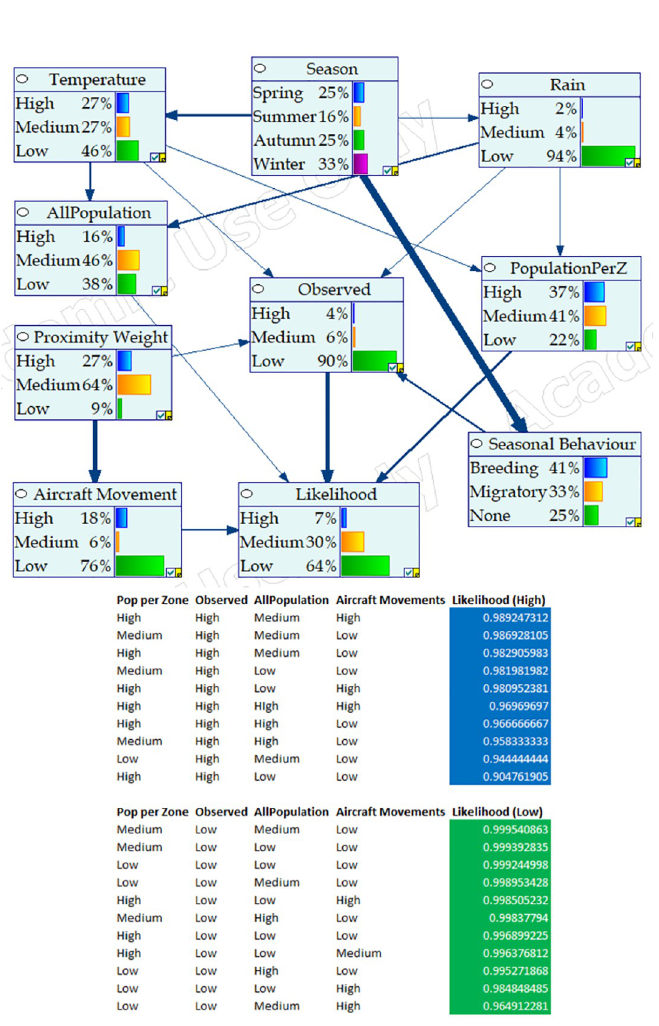
Fig 4. BNM configuration for Cattle Egret including conditional probabilities and indicative variables for high and low collision likelihood. Node influence strength is given by the width of connecting arcs.